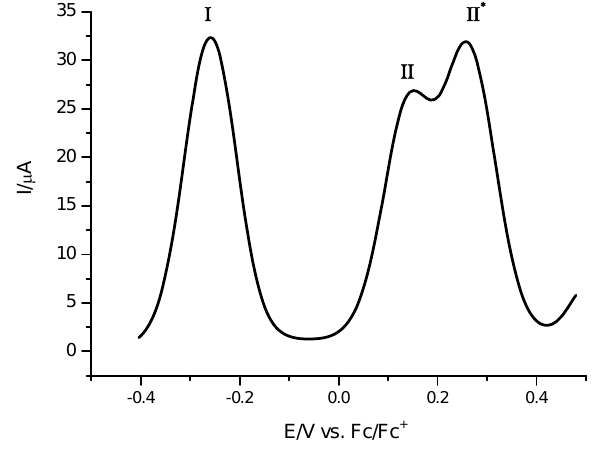
Figure 7. Square wave voltammetry obtained for 10a in the presence of 0.1 M TBABF acetonitrile. Amplitude of 50 mV with a frequency of 10 Hz and initiated from E positive direction. The working electrode used was a platinum